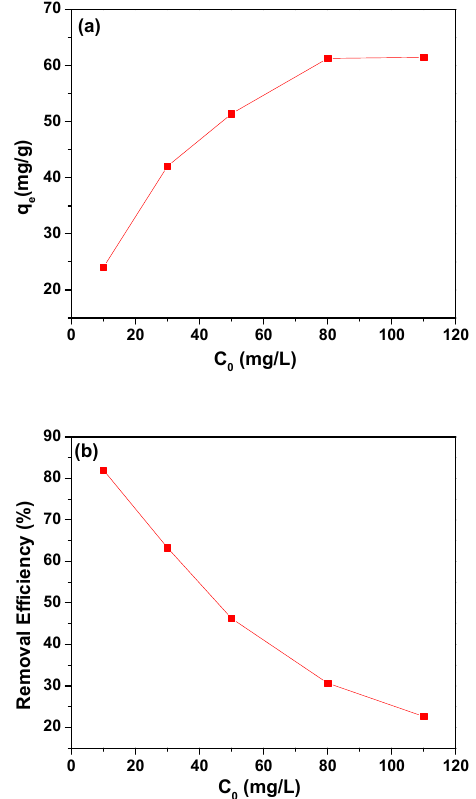
Figure 5. Effect of initial concentration of As(III) on ( a ) the equilibrium adsorption capacity and ( b ) removal efficiency of As(III) onto 3% MIL-53(Al)-GO ( M / V = 0.4 g/L, pH = 6.1, and T = 298 K). Removal efficiency of As(III) in 3% MIL-53(Al)-GO was calculated using Equation (2). As shown